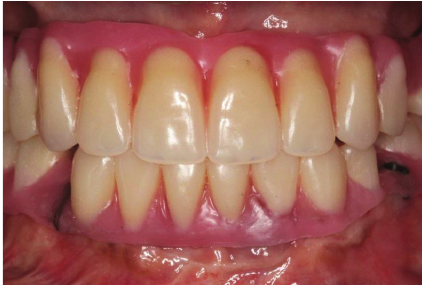
Figure 4: Digital preview of the maxillary monolithic prosthesis.